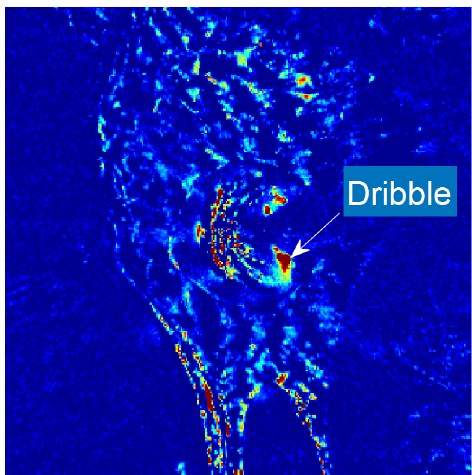
Figure 8. Total scattering signal change rate at medium load.